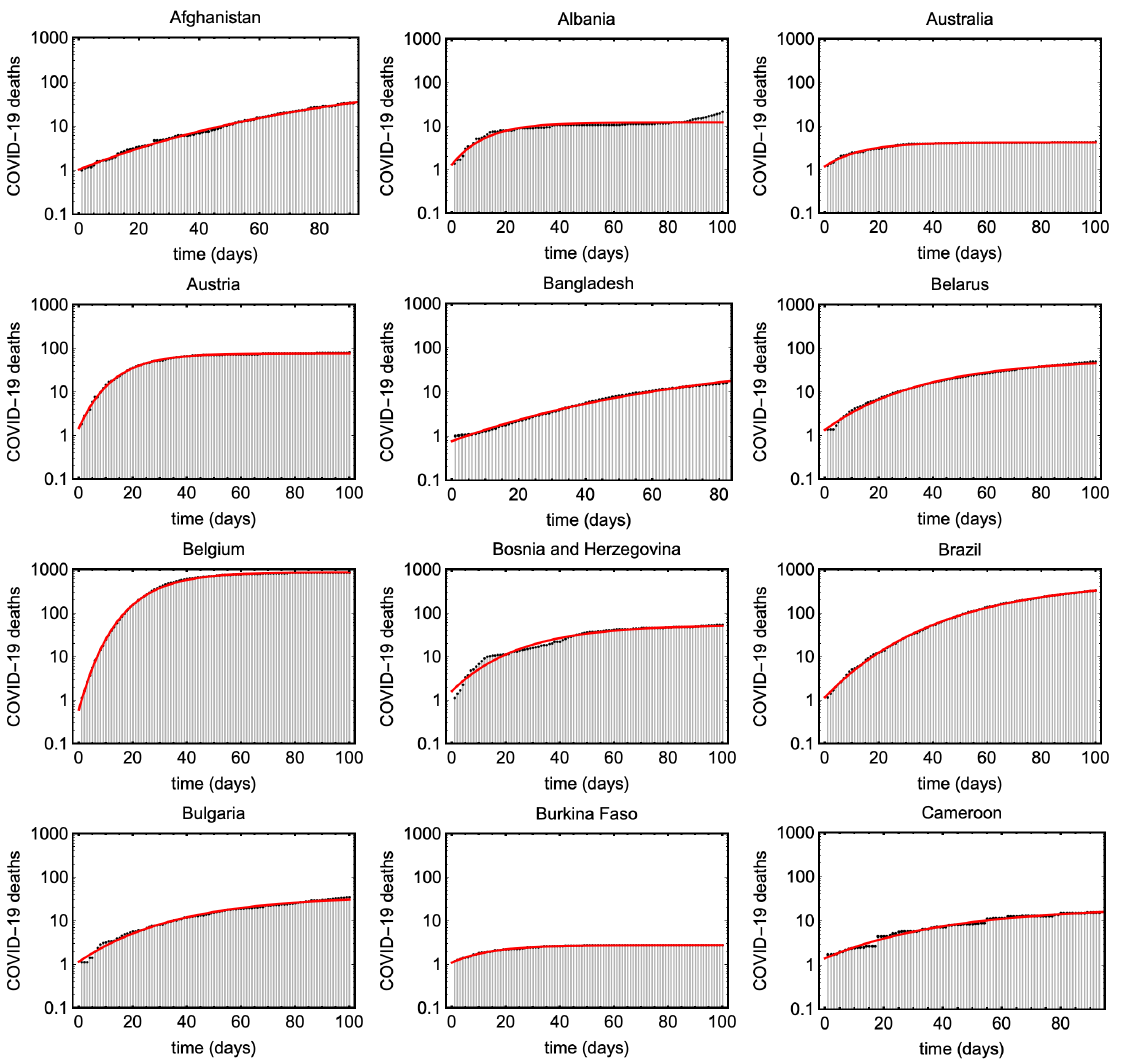
Figure A2. Shows cumulative COVID19 deaths (black) and the estimated Gompertz curves for different countries